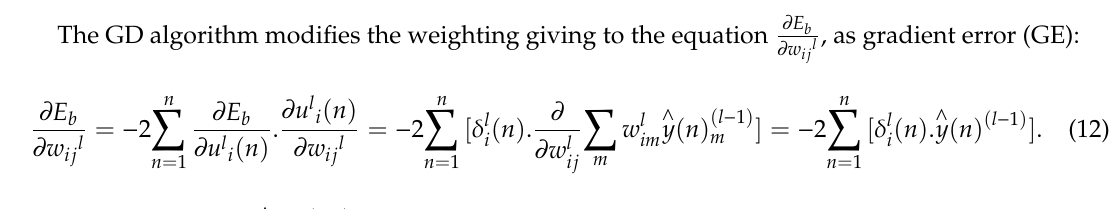
Figure 3. A multiple-layer MLP neural network